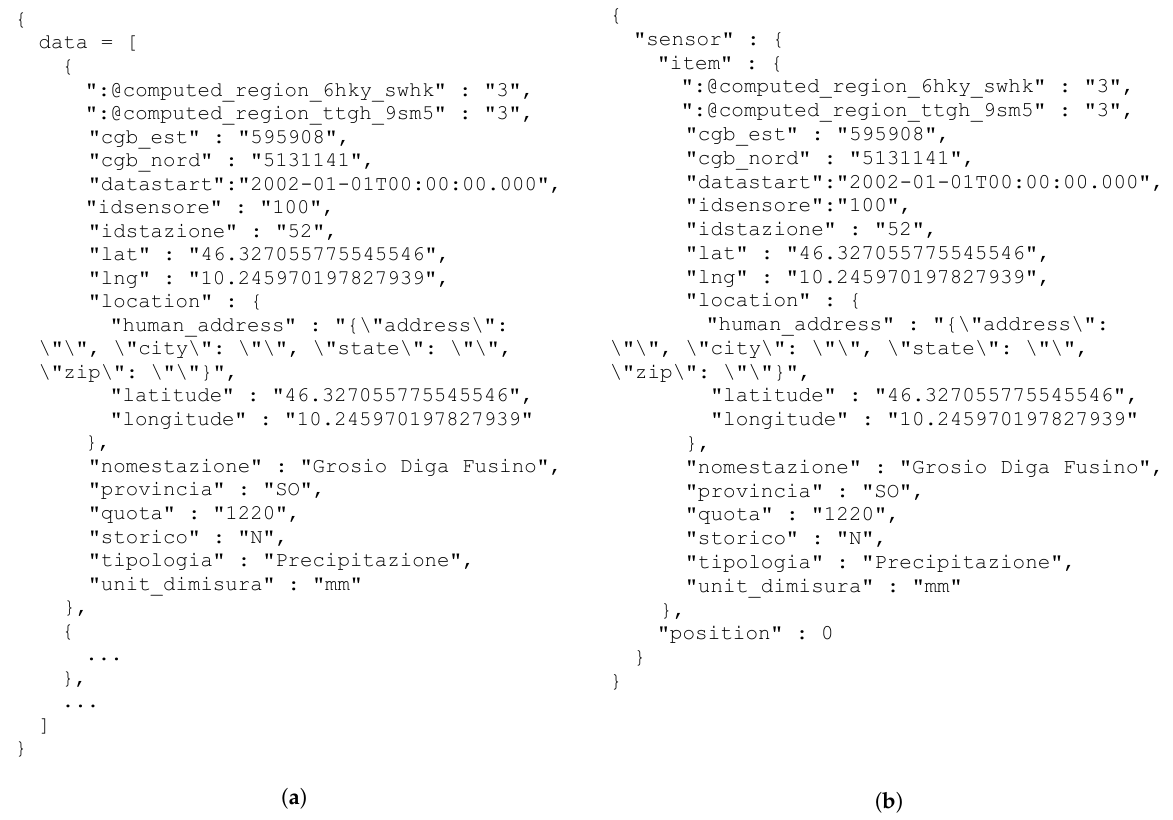
Figure 4. Example of documents generated by line 2 ( a ) and by line 3 ( b ). ( a ) Excerpt of the beginning of the document obtained from the portal with data about weather sensors. ( b ) Example of the document obtained after unnesting documents received from the portal about weather